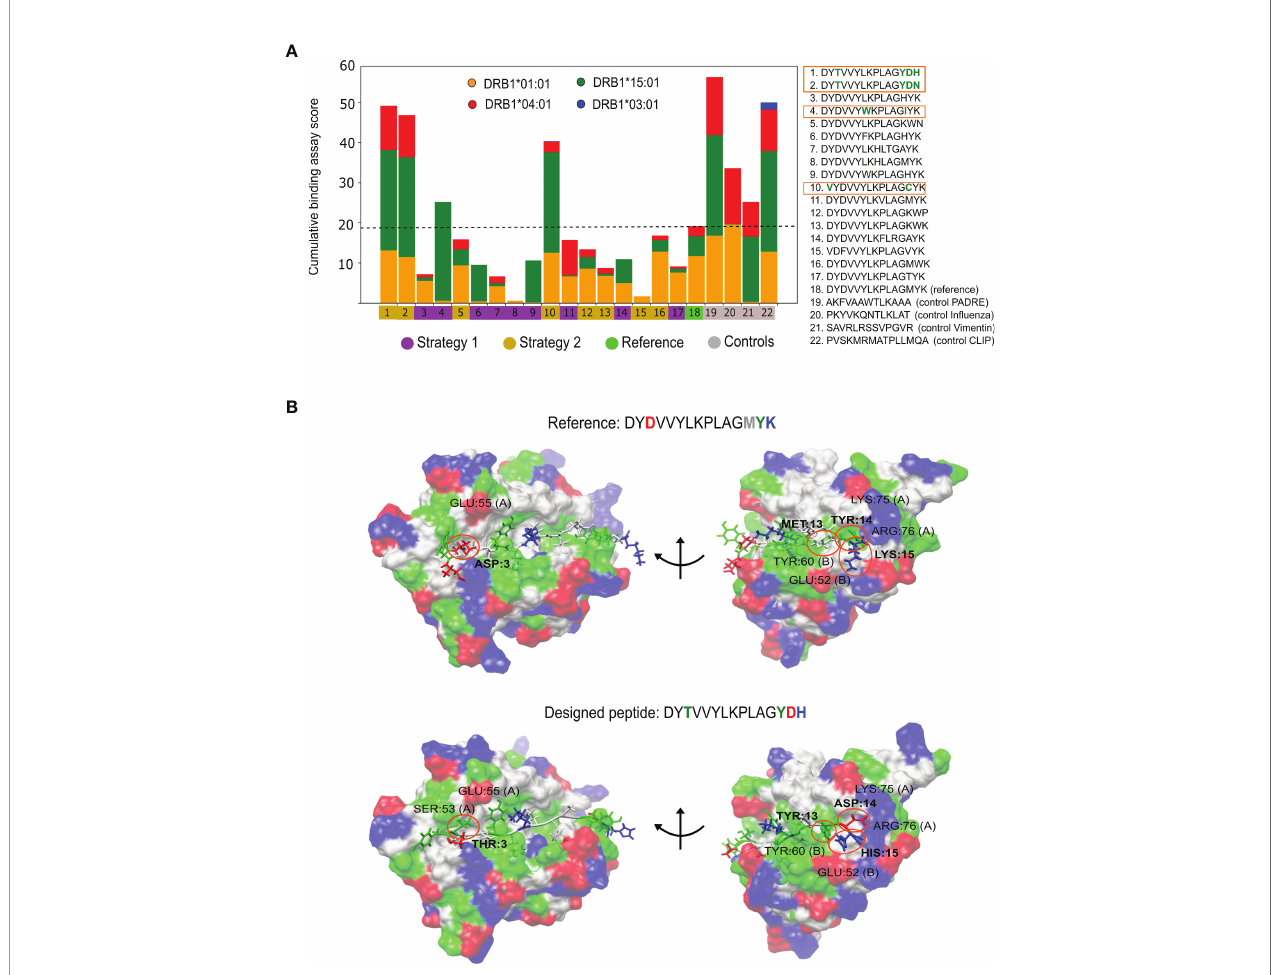
FIGURE 4 | Experimental fi ndings for the P. vivax engineered peptides. (A) Cumulative Multiple-allele REVEAL score for the selected peptides and the controls toward the four alleles included in the study. The human MHC II (HLA) alleles are represented as: DRB1*01:01 in orange, DRB1*15:01 in green, DRB1*04:01 in red and DRB1*03:01 in blue. The peptides with the best experimental results are enclosed in orange. The black dash line is the activity achieved by the reference peptide, values above it indicate a better performance. (B) Bound conformation of best designed peptide (bottom) and the reference peptide (top) to the DRB1:01*01 allele. Representative structures are taken from the long MD simulations. The mutated amino acids are shown in bold in the sequences, and labeled on the structures to highlight their physical interactions. Acidic amino acids are colored in red, basic in blue, polar in green and non-polar in